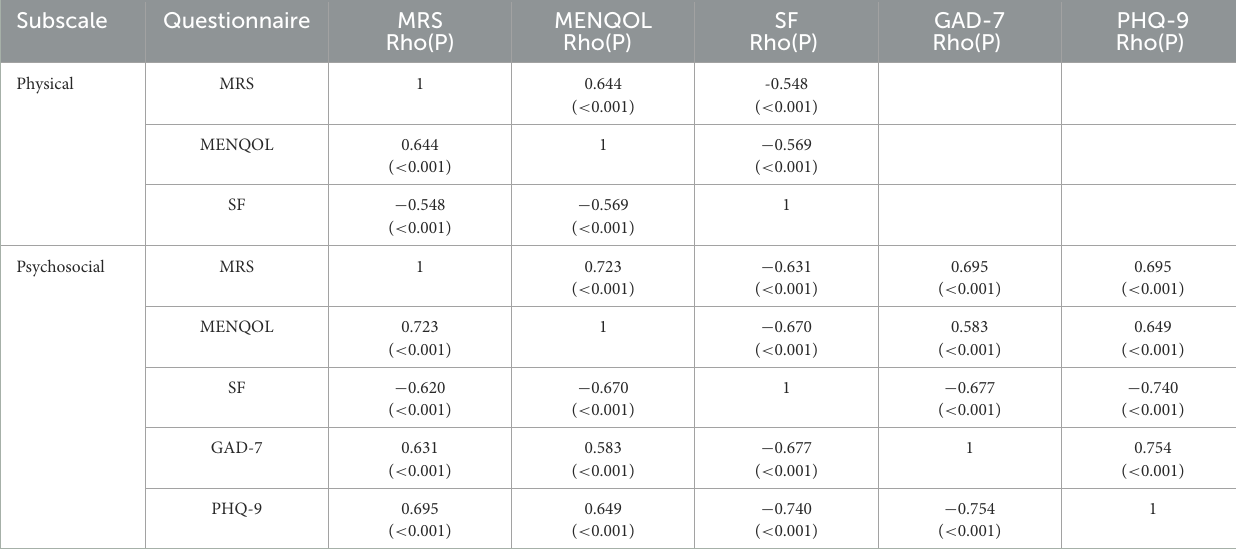
TABLE 4 Correlations among Quality of life scales of participants after HSCT measured by the Spearman rank correlation coefficient.